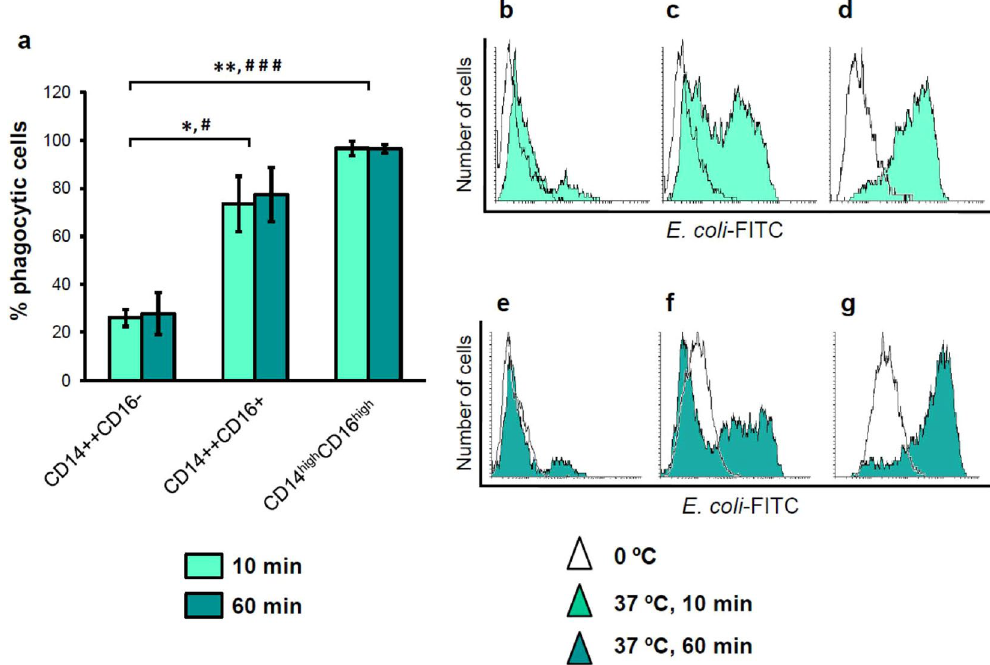
Figure 4. Flow cytometry analysis of the phagocytic activity of human peritoneal monocyte/macrophages. Phagocytosis was analyzed by measuring intracellular FITC-labelled E. coli fluorescence. Percentages of phagocytic cells were comparatively analyzed among the three different peritoneal subpopulations after incubation with the FITC-labelled E. coli for 10 minutes (bright aquamarine bars) and 1 hour (dark aquamarine bars) ( a ). Bars represent percentages of phagocytic cells into the three peritoneal subsets indicated as mean ± SEM percentage of FITC-positive cells referred to the totality (100%) of cells into the correspondent subset. Mann-Whitney U test among the three subsets: * p < 0.05, ** p < 0.01, for the percentage of phagocytic cells after 10 min incubation; and # p < 0.05, ### p < 0.001, for the percentage of phagocytic cells after 1 hour incubation with FITC-labelled E. coli . Representative FACS histograms of engulfed bacteria per cell, measured as fluorescence in FITC channel, for every peritoneal subset are also displayed for 10 min assays: CD14 ++ CD16 − ( b ), CD14 ++ CD16 + ( c ) and CD14 high CD16 high ( d ); and for 1 hour assays: CD14 ++ CD16 − ( e ), CD14 ++ CD16 + ( f ) coloured histograms to FITC signal at 37 °C for the corresponding time